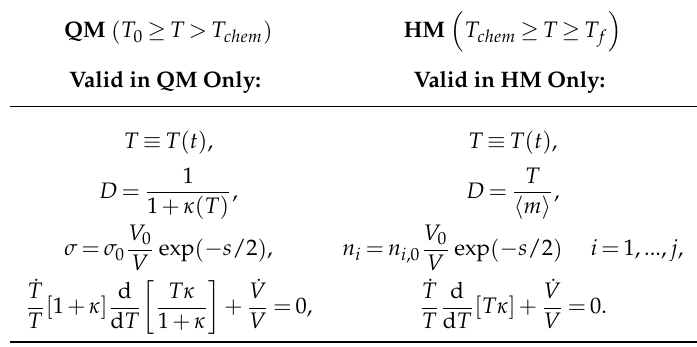
Table 5. Equation of state dependent part of new, exact, rotating solutions of fireball hydrodynamics, that completes Table 4. In this table, those parts are shown that are specific to the time evolution of quark matter or hadronic